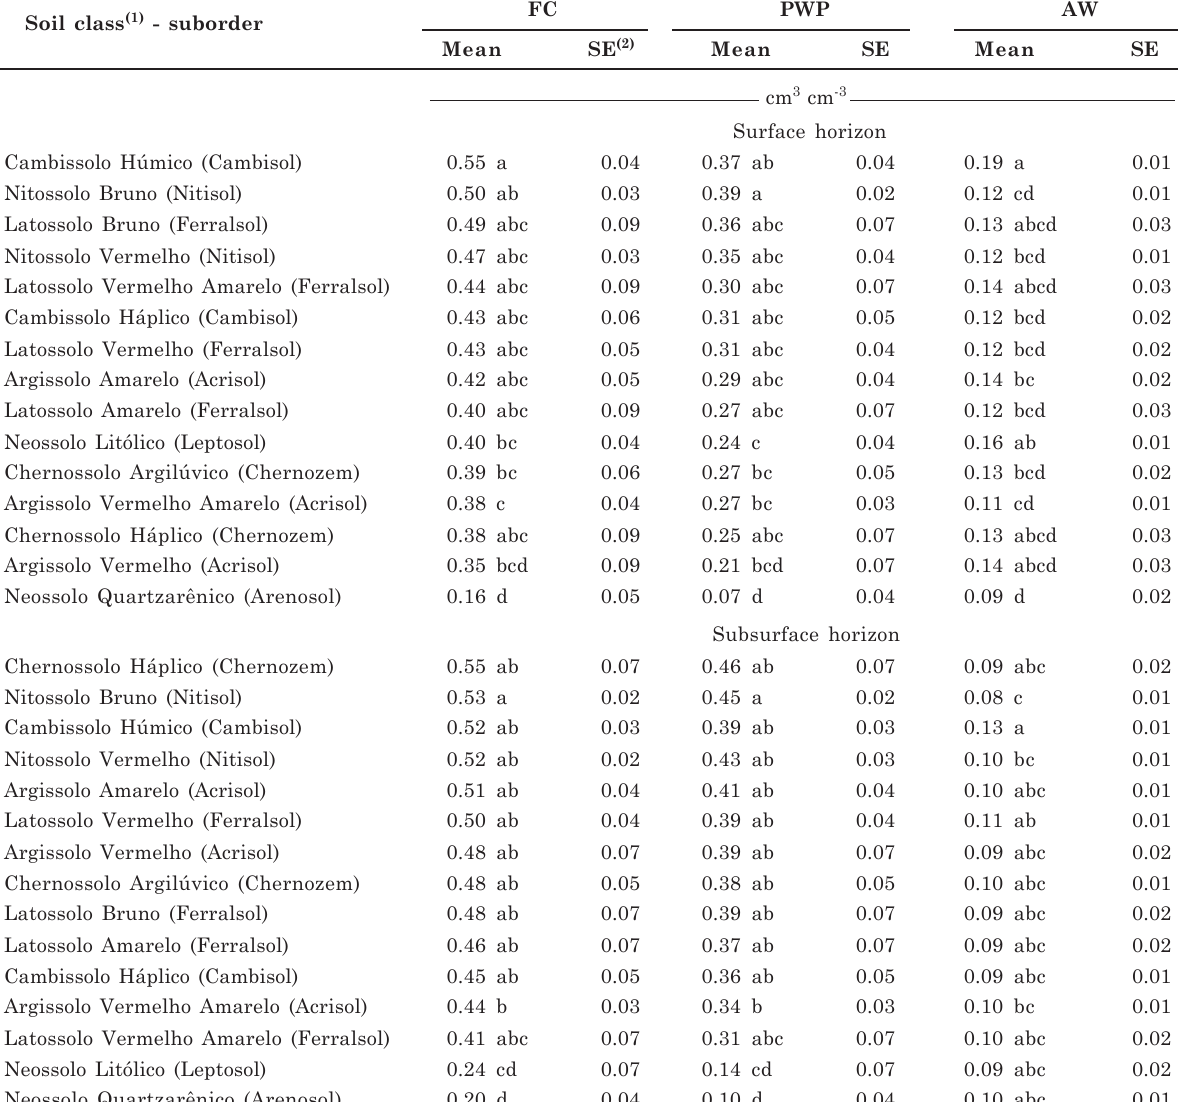
Table 3. Soil moisture at field capacity (FC), permanent wilting point (PWP), and available water content (AW), in different soil classes in the State of Santa